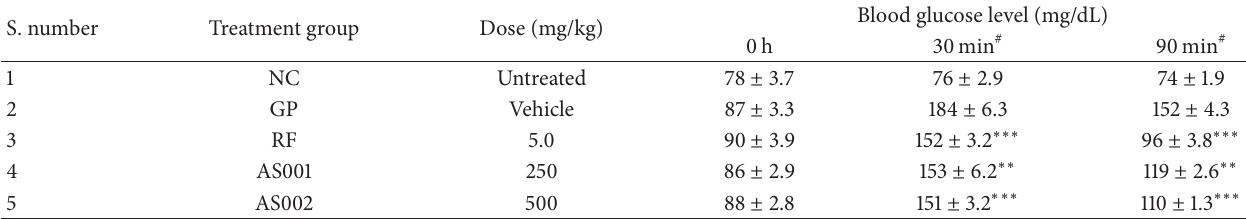
Table 2: Effect of Pupalia lappacea in blood glucose primed rats.